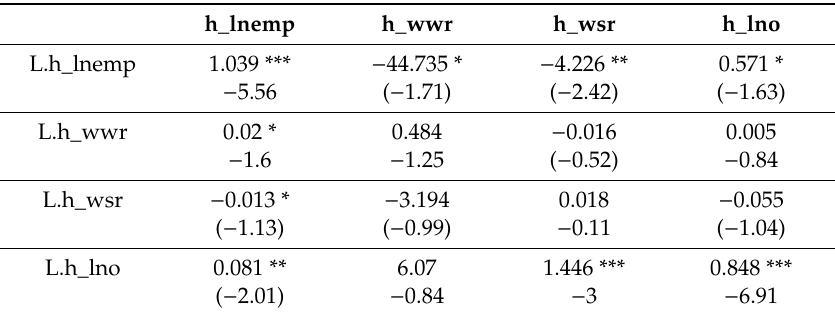
Table 9. PVAR estimation results of dirty